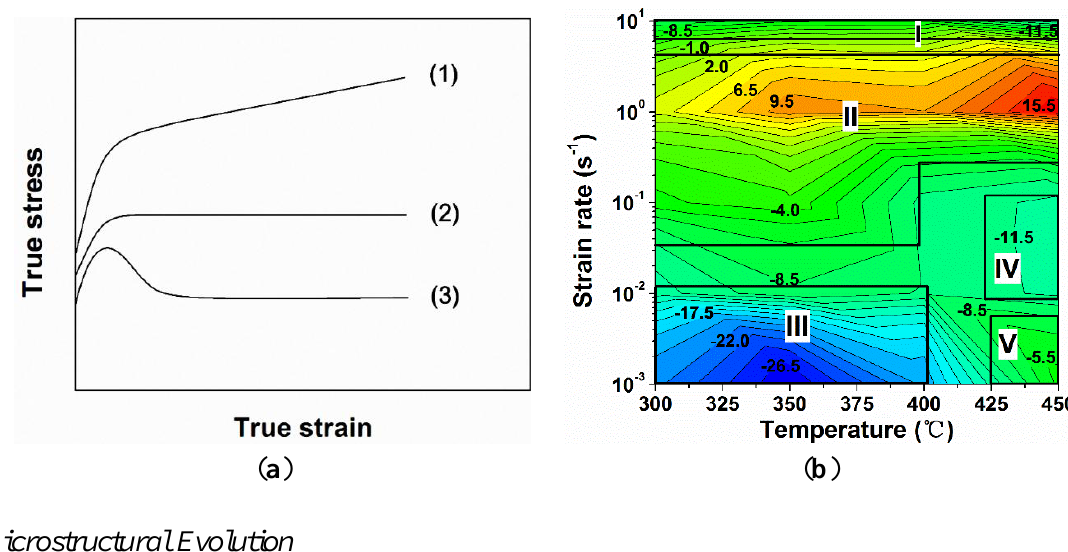
Figure 3. ( a ) Schematic illustration of the evolution of true stress-true strain curves in three cases; ( b ) decline ratio map of flow stresses, R temperature and strain rate.